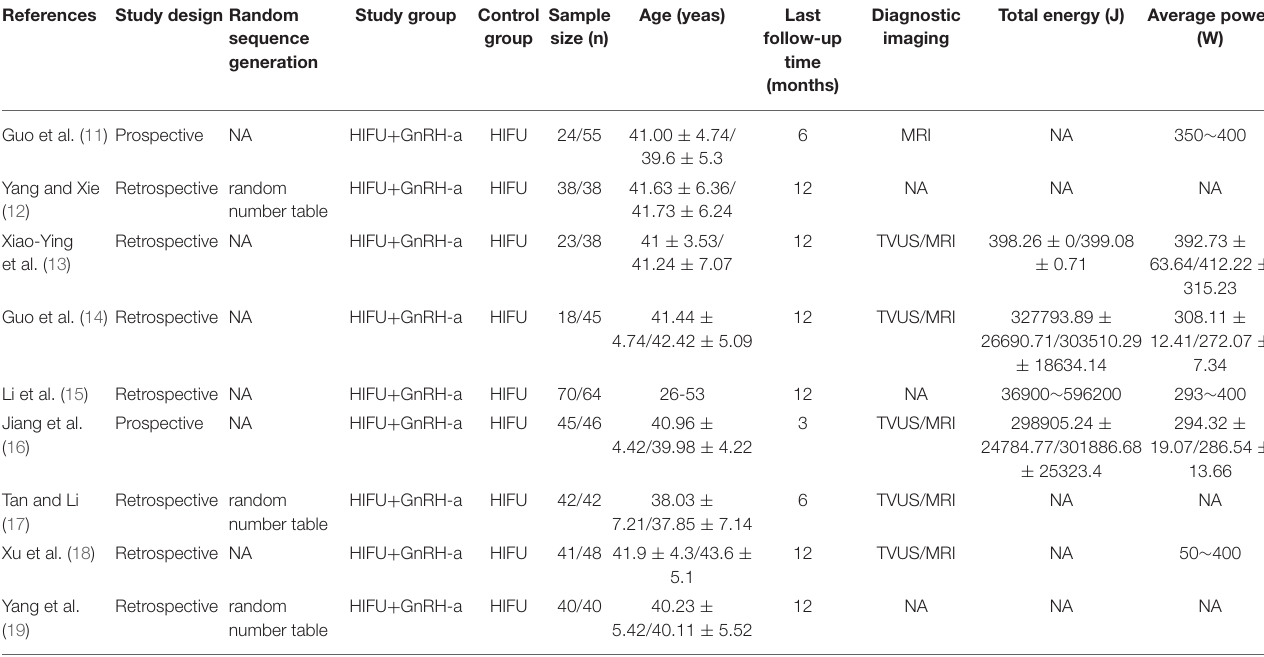
TABLE 1 | Characteristics of included